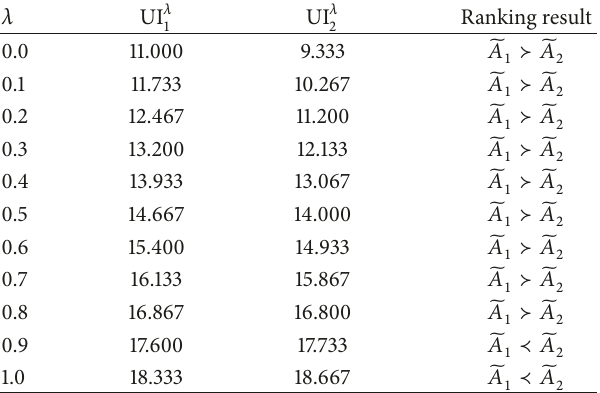
Table 5: Ranking results at different optimism levels in Example